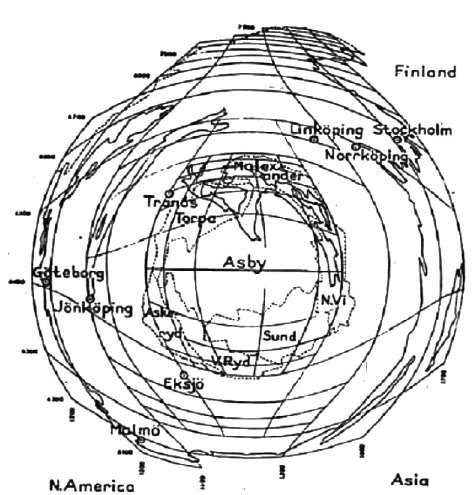
Fig. 16. Map of migration around the Swedish town (T. Hägerstrand 1957)